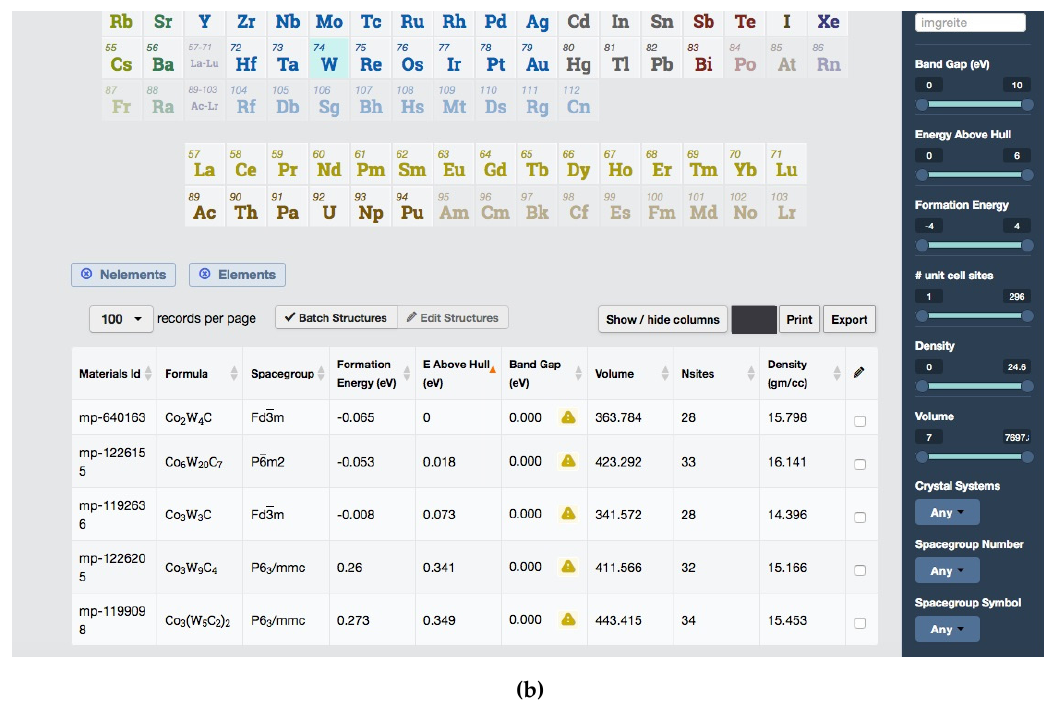
Figure 18. Search results for W–C–Co in two state-of-the-art computational data repositories. (a) In NOMAD [267]. (b) In the Materials Project [276].